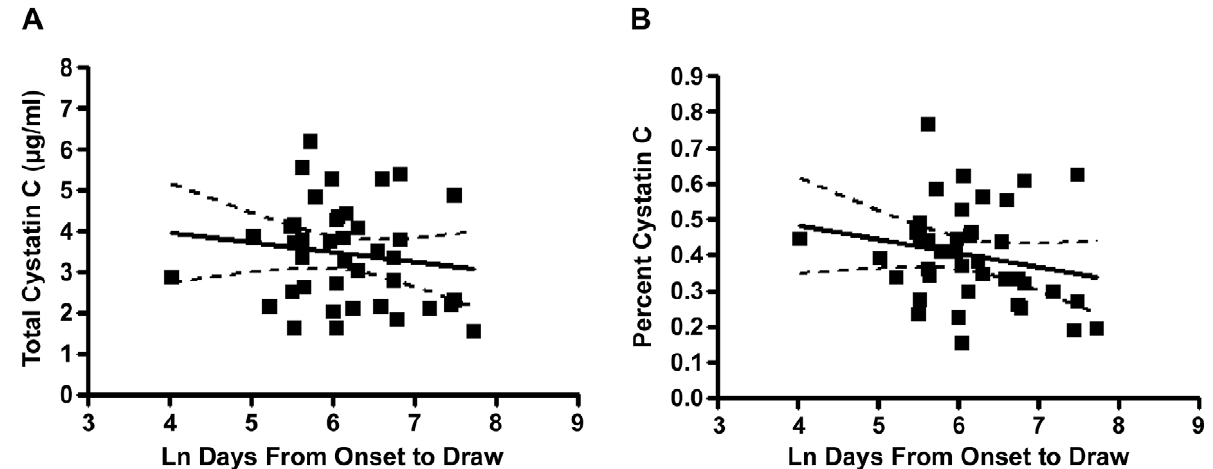
Figure 1. Linear regressions for CSF cystatin C levels vs. time from symptom onset. The slope of the best-fit lines (solid) for both total ( A ) and percent ( B ) cystatin C did not significantly differ from zero ( p =0.368 and p =0.193, respectively). Dashed line=95% confidence interval for best- fit line.